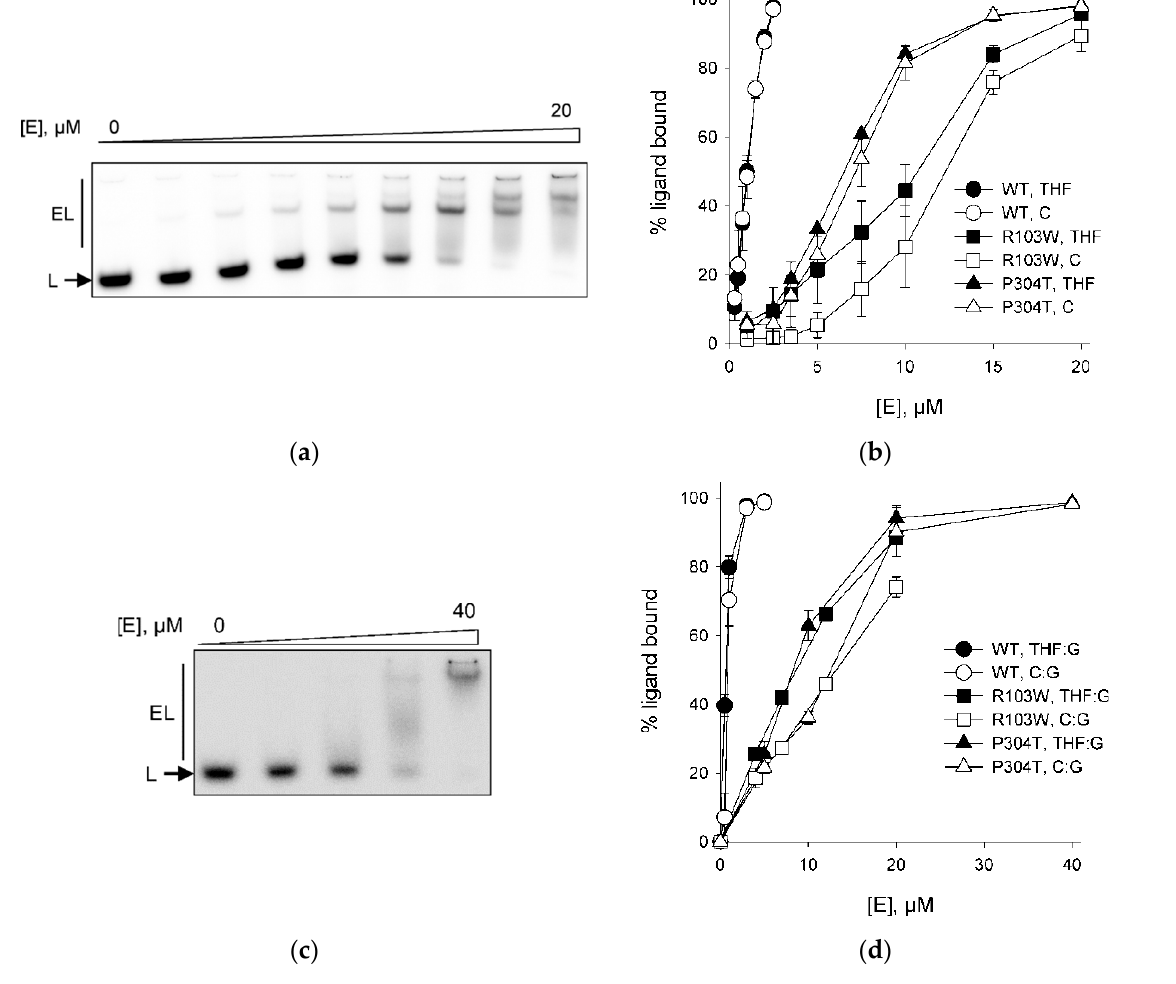
Figure 4. Binding of normal and damaged DNA by hNEIL2. ( a ) Representative gel showing shifting of THF-containing bubble DNA ligand by hNEIL2 P304T (0–20 µ M). L, THF bubble ligand; EL, enzyme–ligand complexes. ( b ) Plot of fractional THF bubble binding vs enzyme concentration. Mean ± s.e.m. is shown ( n = 3). ( c ) Representative gel showing shifting of THF:G-containing DNA duplex by hNEIL2 P304T (0–40 µ M). L, THF:G ligand; EL, enzyme–ligand complexes. ( d ) Plot of fractional THF:G binding vs enzyme concentration. Mean ± s.e.m. is shown ( n =